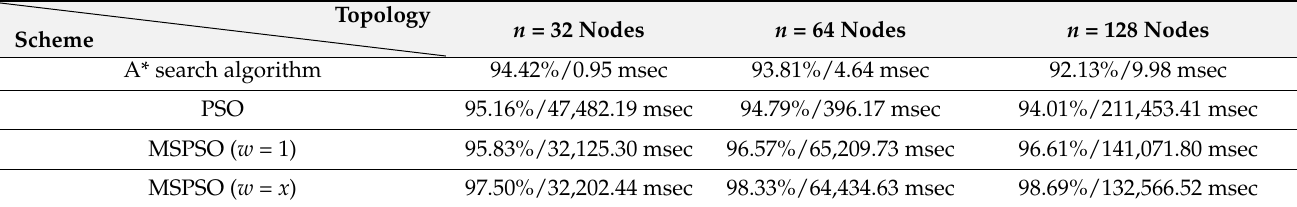
Table 7. Traceback accuracy vs. execution time of DDoS attacks when using the proposed algorithm with two path-search